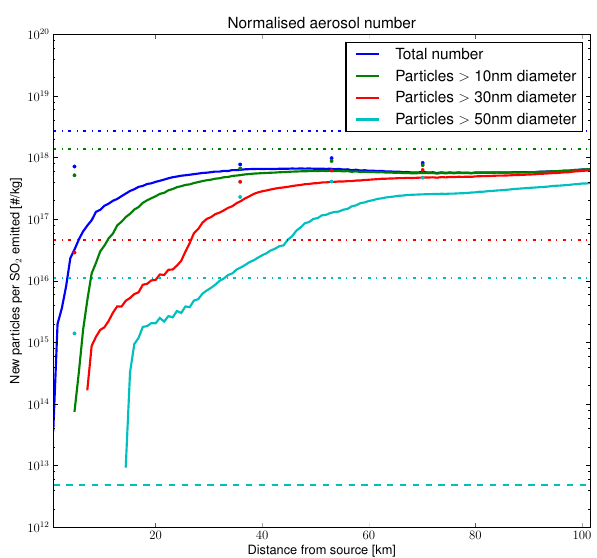
Fig. 4. Additional predicted particles per kg SO 2 versus distance from the Parish power plant, summed over the plume. Model res- olution is 800 × 800 × 40m. Dots indicate aircraft observations, solid lines indicate model results, dashed lines indicate the val- ues used by Dentener et al. (2006), and dashed-dotted lines indi- cate the values used by Adams and Seinfeld (2003). Coloring indi- cates size range of particles. Essentially all particles in the Dentener et al. (2006) distribution are larger than 50nm, so all dashed lines overlap one